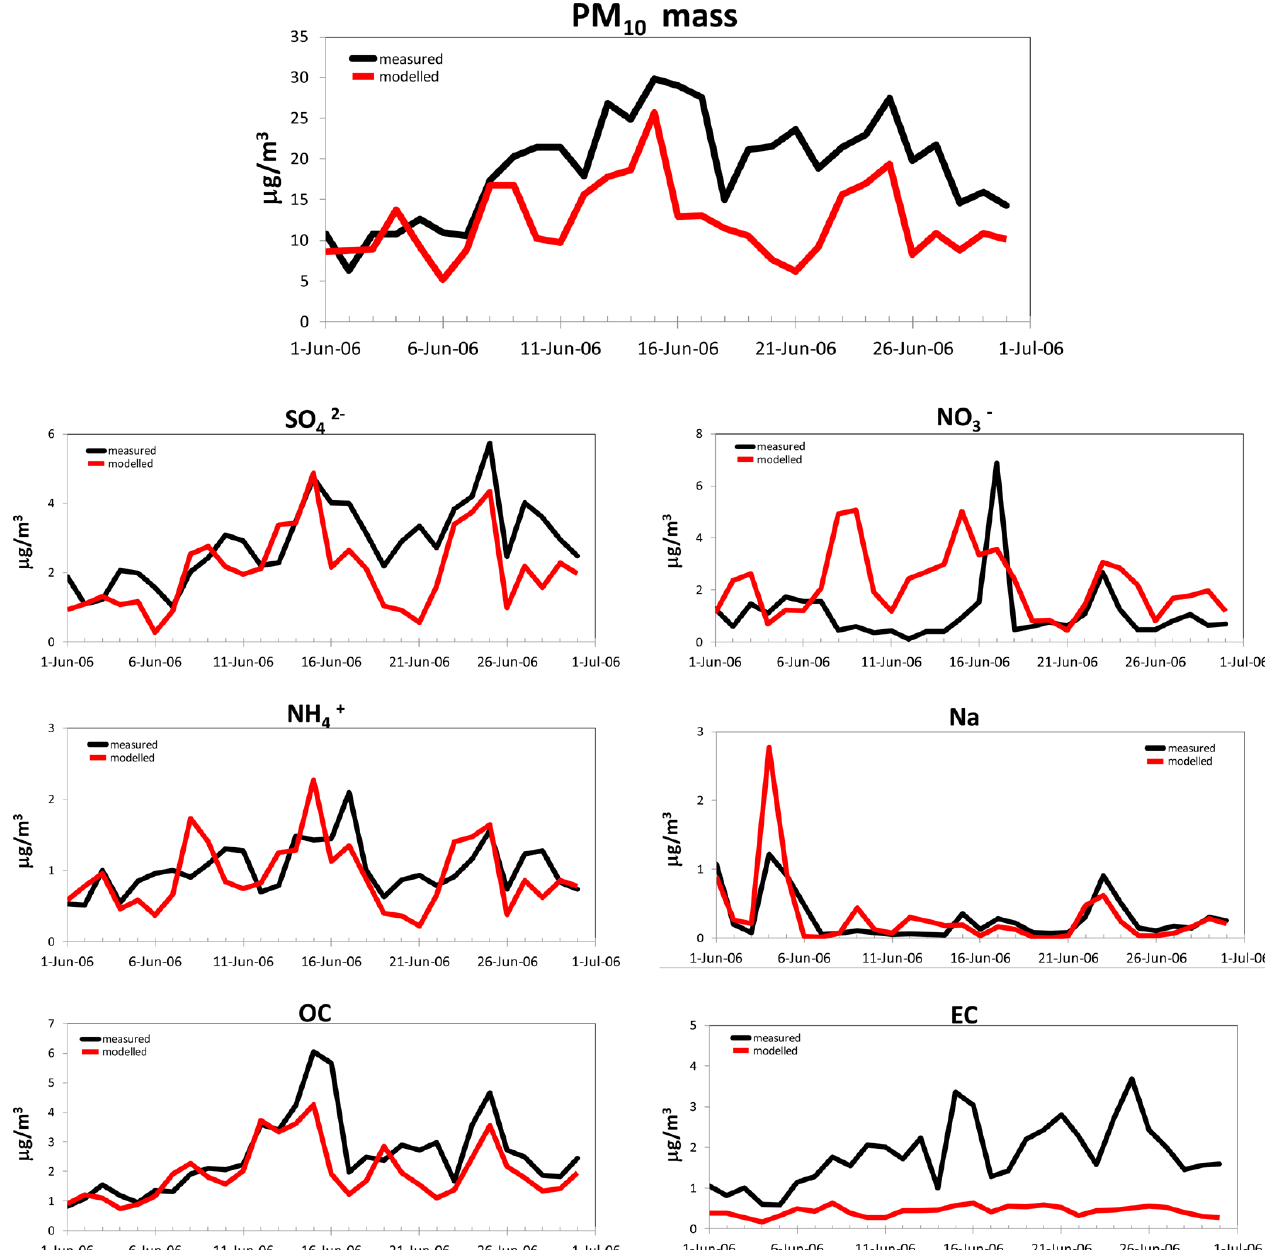
Fig. 6. Daily chemical speciation in PM 10 at Melpitz (DE44) in June 2006 from measurements (black) and EMEP model (red).